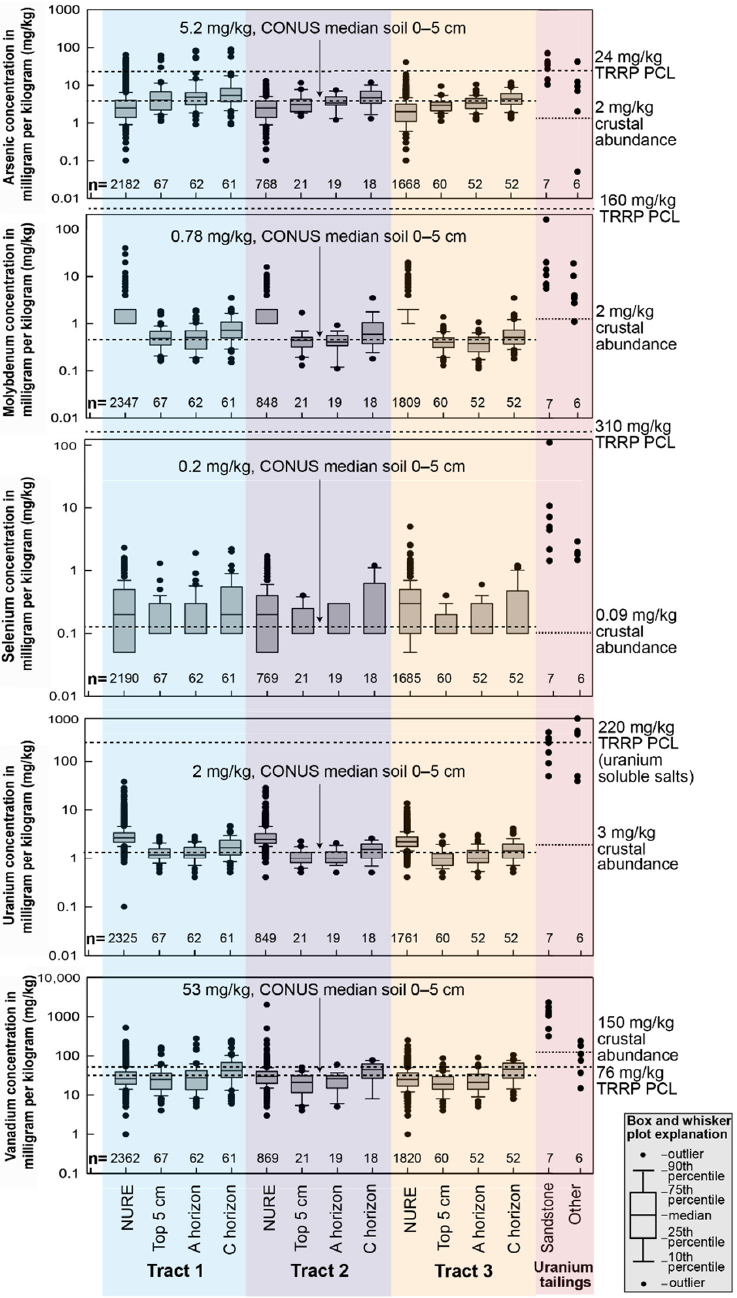
Figure 5. Arsenic, molybdenum, selenium, uranium, and vanadium concentrations in stream sediments from NURE [57,58]; USGS soils from [59,60] (Top 5 centimeter (cm), A horizon, C horizon); from sandstone-hosted uranium deposit tailings from mills in Utah and Colorado [62,63]; and from other types of uranium deposit tailings including unconformity uranium deposits; intrusive (pegmatitic) deposits; quartz-pebble conglomerate deposits; and metasomatic deposits from [62,64]. Stream sediment and soil data are grouped into permissive tracts 1, 2, and 3. The Texas Risk Reduction Program total soil combined pathway for residential 0.5-acre source area noncarcinogenic human-health protective concentration levels (TRRP PCL) [61] are shown. In addition, the median concentrations reported in 0–5 cm depth for soils in the United States ([Conterminous United States] CONUS median soil 0–5 cm) [59] and crustal averages from [65] are shown for comparison.